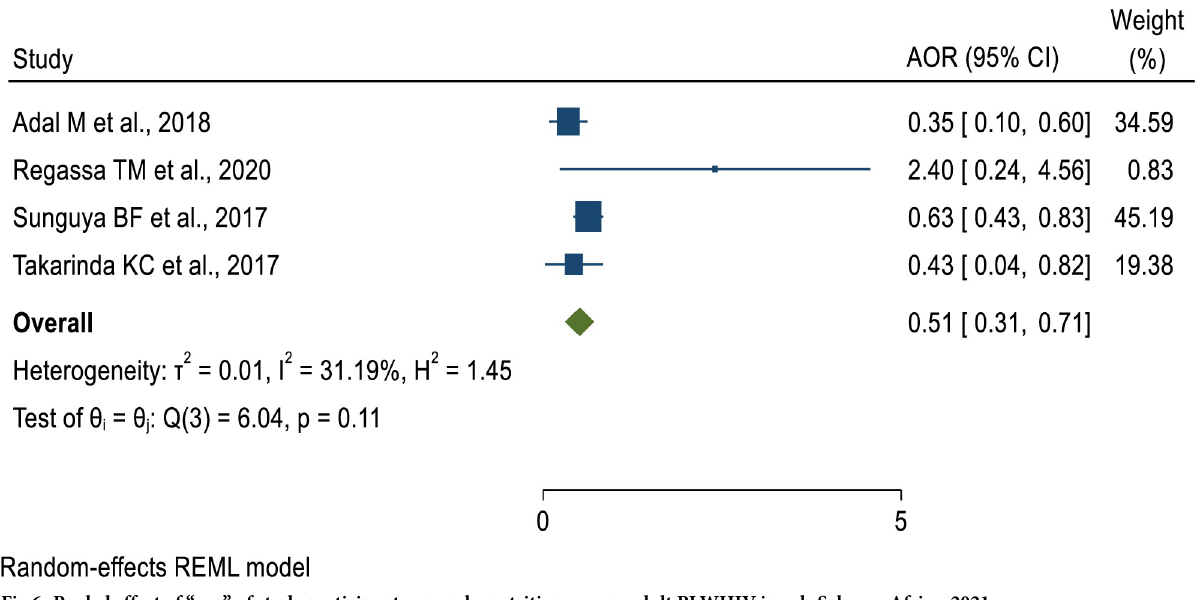
PLOS ONE | https://doi.org/10.1371/journal.pone.0283502 March 24, 2023 12 /